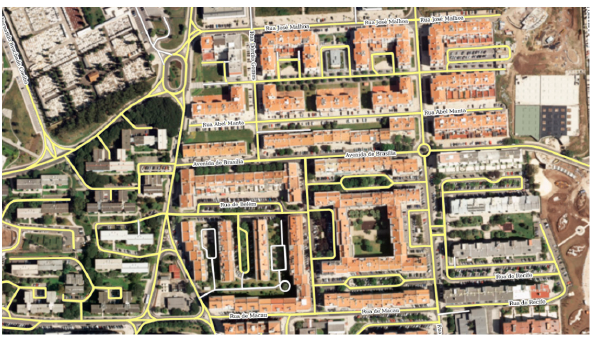
Figure 4. Road axis.